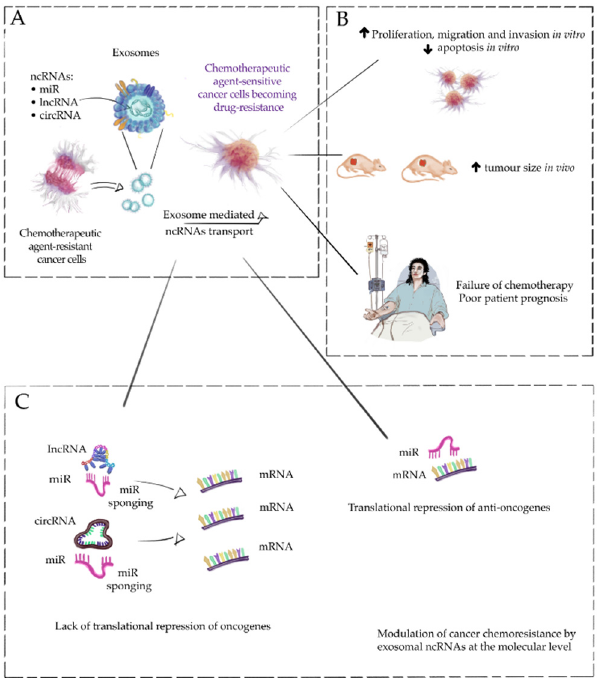
Figure 1. A simplified role of exosomal non-coding RNAs (ncRNAs) in developing cancer cells’ resistance to chemotherapeutic agents. Chemotherapeutic agent-sensitive cancer cells may become drug-resistant through exosomal transport of ncRNAs. Chemotherapy-resistant cancer cells can